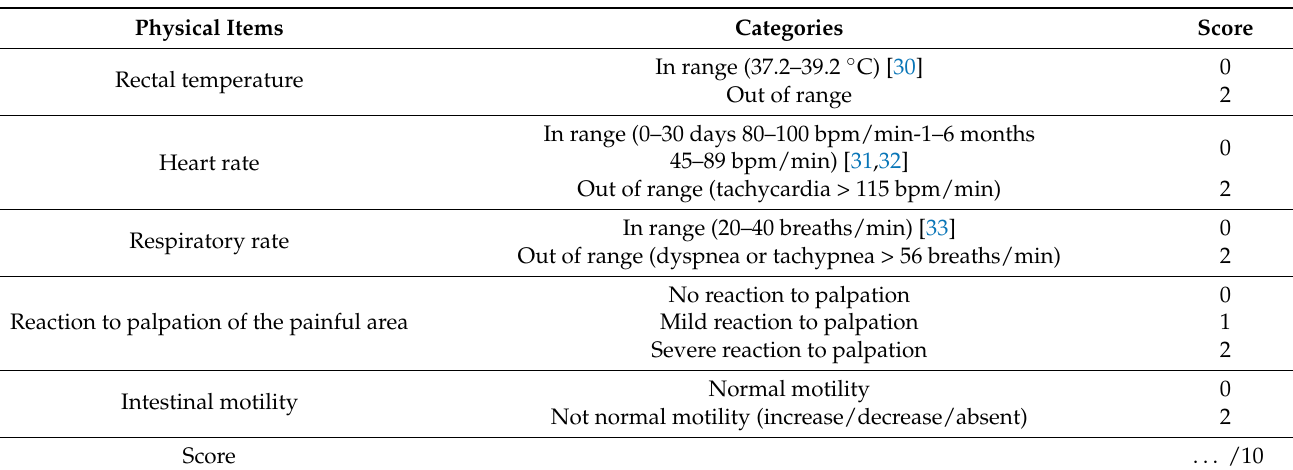
Table 5. Score sheet of Section III of FCPS: Physical items. This section was developed and adapted from Bussieres et al., 2008; Bernard, 2004